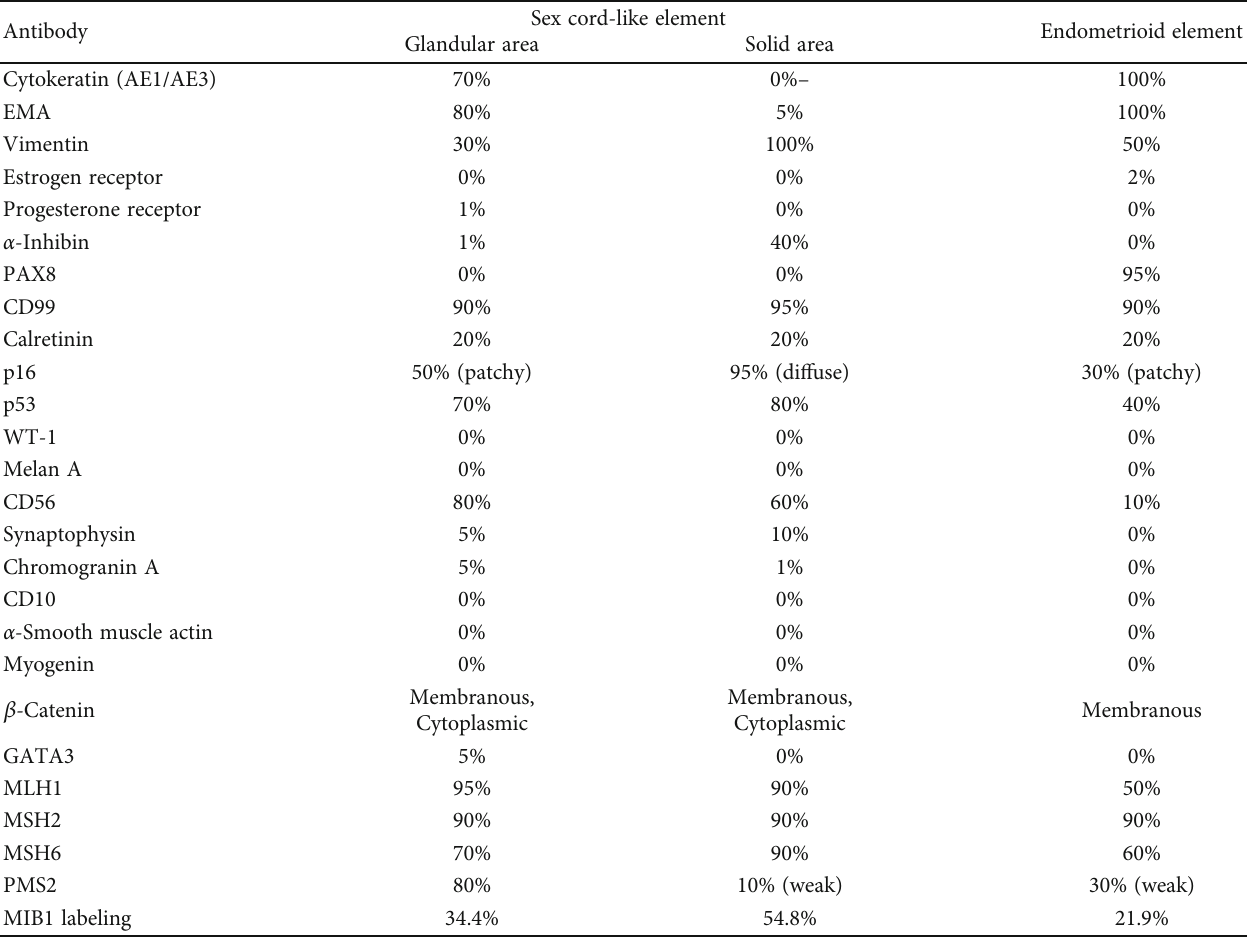
Table 2: Results of immunohistochemistry for each histological